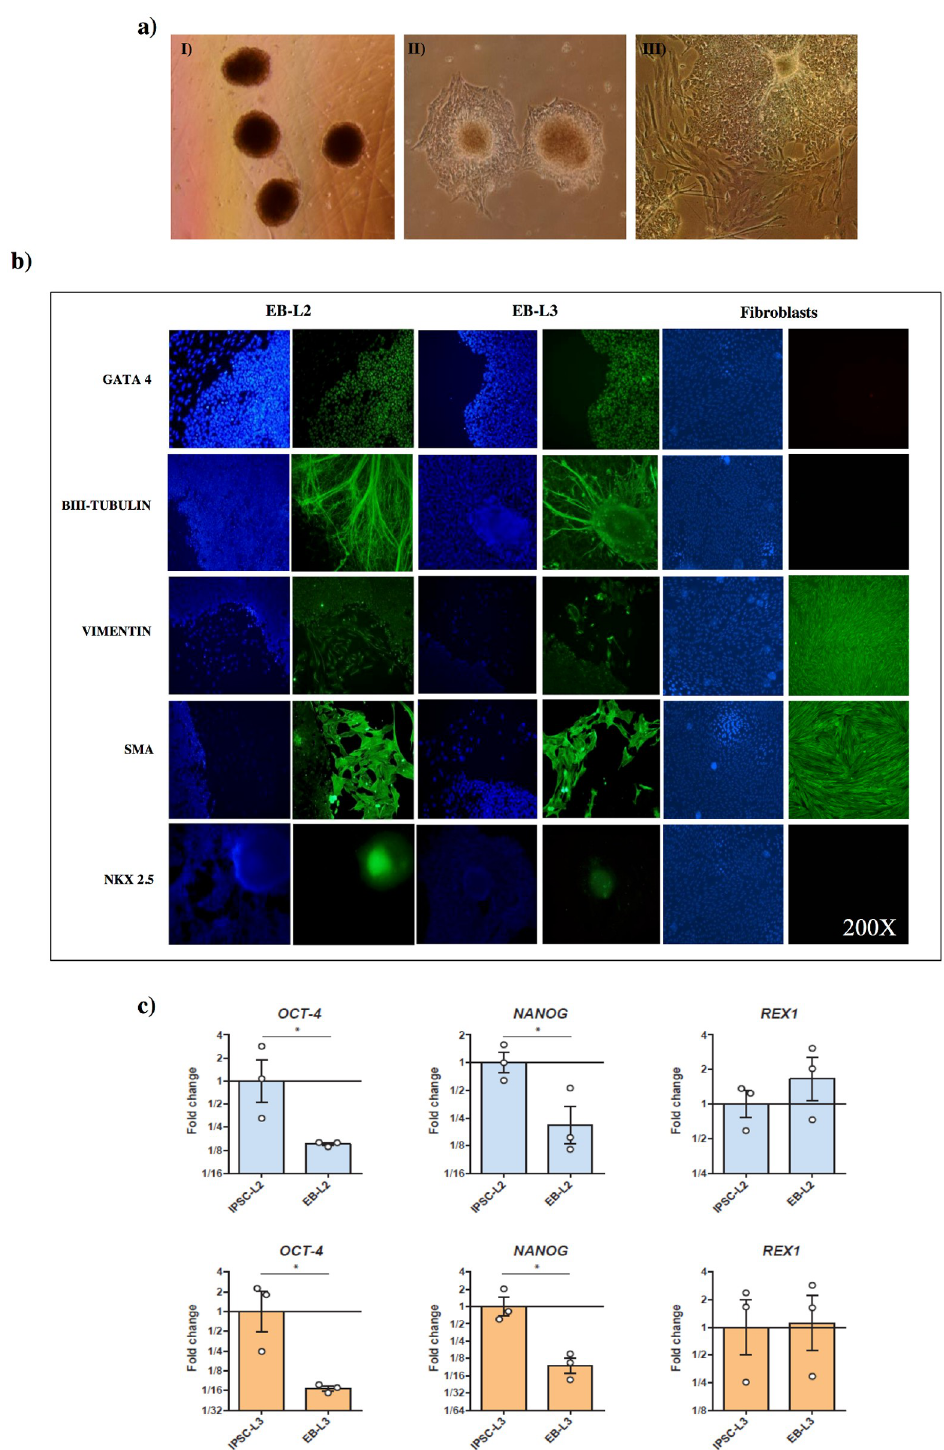
Fig 3. In vitro differentiation of L2 and L3 iPSCs to embryo bodies (EB). a) Generation of EBs, I) EBs in suspension for 1 week in DMEM medium, II) EBs after 3 days in adherent dishes, III) EBs after 2 weeks in adherent dishes; b) Inmmunofluorescence of endodermal, ectodermal and mesodermal markers in EBs derived from L2 (EB-L2), L3 (EB-L3) iPSCs lines and fibroblasts as controls. In blue nucleous are stained with DAPI c) RT-qPCR analysis of pluripotent markers in L2 vs . EB-L2 and L3 vs . EB-L3. Results are presented as means ± SEM (n = 3). Data were relativized to L2 or L3 for EB-L2 and EB-L3, respectively. � Statistically different (p < 0.05).